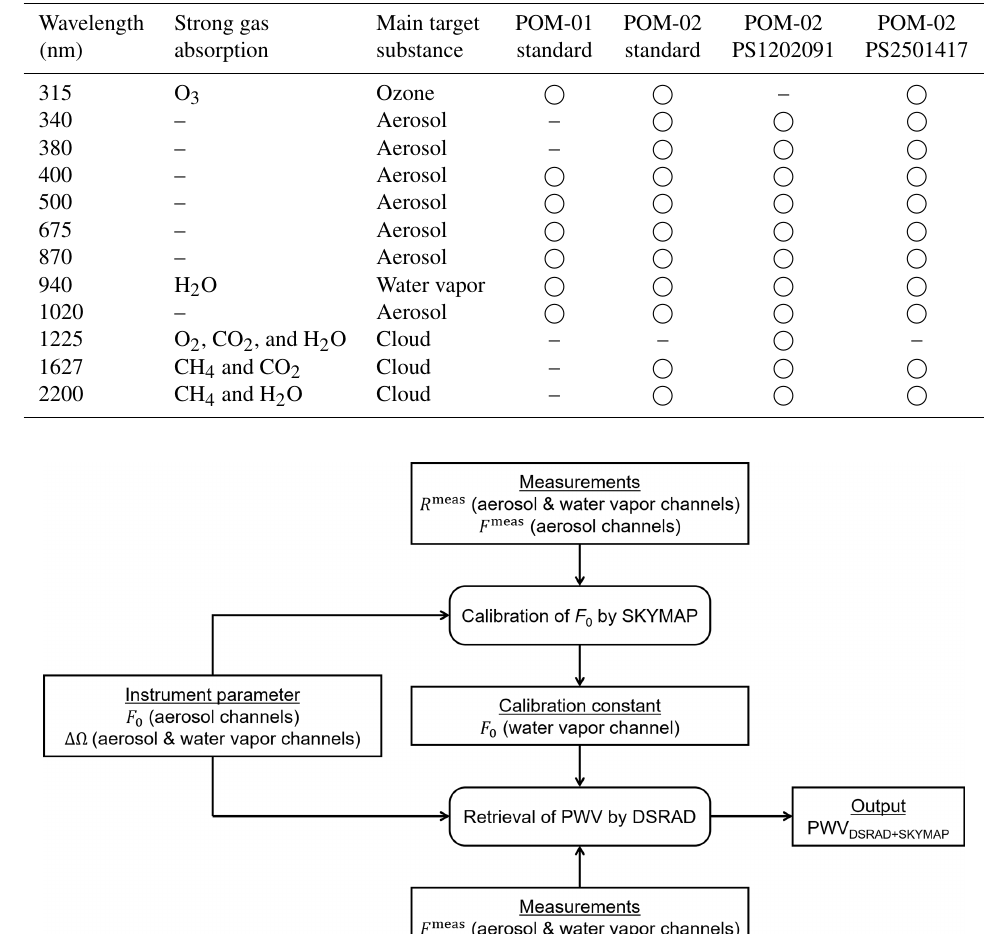
Table 1. Sky-radiometer specifications. Each sky radiometer is equipped with a filter indicated by a circle. “Standard” is the standard specification of sky-radiometer models POM-01 and POM-02.